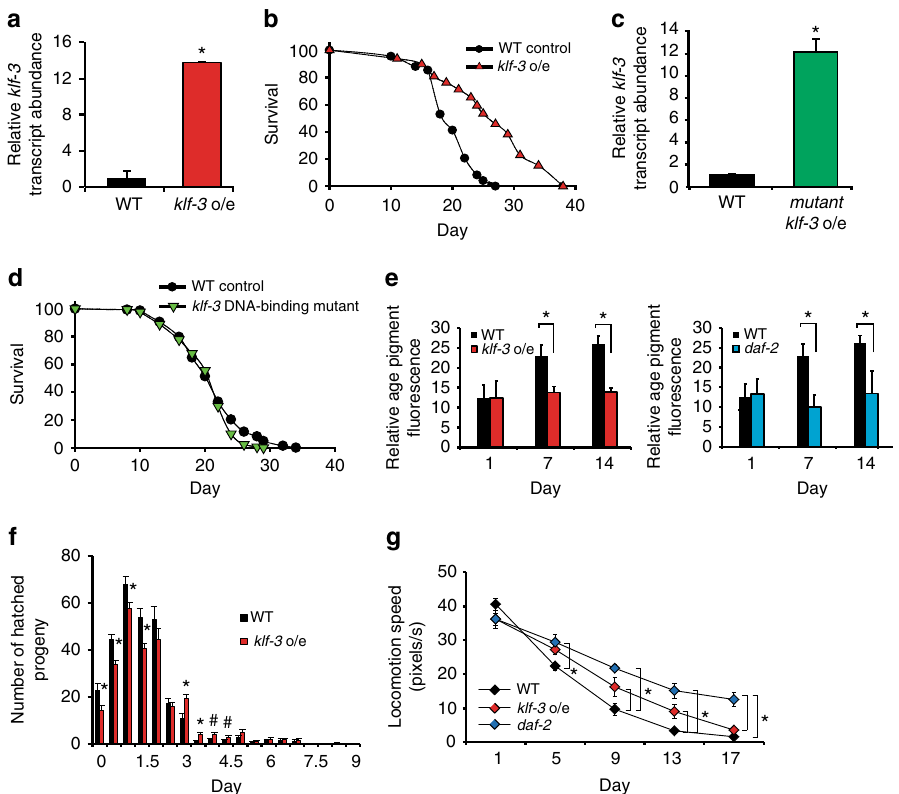
Fig. 2 Klf-3 overexpression extends health and lifespan in C. elegans . a klf-3 transcript levels in day 1 wild-type and klf-3 o/e animals overexpressing klf-3 driven by putative endogenous promoter as determined by qPCR. Animals were fed OP50 and maintained at 20 °C. Signi fi cance determined by Student ’ s T -test, * P -value < 0.05. N = 3 biological replicates. b Lifespan analysis of klf-3 o/e animals compared to wild type maintained at 20 °C on OP50. P -value < 0.05 by Mantel – Cox log-rank tests. See also Supplementary Table 4 for details of lifespan analyses and replicate experiments. c Mutant klf-3 transcript levels in day 1 animals overexpressing mutated klf-3 driven by putative endogenous promoter as determined by qPCR. Animals were fed OP50 and maintained at 20 °C. Mutant klf-3 was created using a 258 nucleotide C-terminal deletion that included the entire zinc- fi nger-containing region. Signi fi cance determined by Student ’ s T -test, P -value < 0.05. N = 3 biological replicates. d Lifespan analysis of klf-3 mutant overexpressing nematodes grown and maintained at 20 °C on OP50. P -value > 0.05 by Mantel – Cox log-rank tests. See also Supplementary Table 4 for details of lifespan analyses and replicate experiments. e Appearance of age-related pigments in klf-3 o/e worms compared to wild-type and daf-2 mutants compared to wild type as measured by auto fl uorescence at 420 – 440 nm ( N = 10 per group). Data collected from the same wild-type animals are displayed in both panels. Animals were fed OP50 and maintained at 20 °C. Prior to imaging worms were anesthetized by sodium azide solution. Student ’ s T -test, * P -value < 0.05. f Reproductive analysis as measured by viable egg-laying by klf-3 o/e and wild-type animals ( N = 10 per group). Worms were transferred every 12 h and viable eggs were counted. Student ’ s T -test, * P -value < 0.05. g Age-related decay in locomotory speed in klf-3 o/e worms compared to wild-type worms and daf-2 mutants ( N = 10 per group). Worms were picked onto fresh NGM plate without OP50 and scored for 2 min before being returned to plate. Otherwise, animals were fed OP50 and maintained at 20 °C. See also Supplementary Movies 1 – 6. * P -value < 0.05 after two-way analysis of variance followed by the Tukey ’ s post hoc test. All error bars represent standard error of the mean regulators of autophagy gene products. Further, nematodes overexpressing klf-3 with a deletion of the zinc fi nger DNA- binding region displayed no signi fi cant changes in transcript levels of the same genes (Supplementary Fig. 7).Consistent with this hypothesis, promoter analyses of these autophagy-related genes revealed one or more consensus KLF-binding elements stream of the transcription start site (Supplementary Table 5).